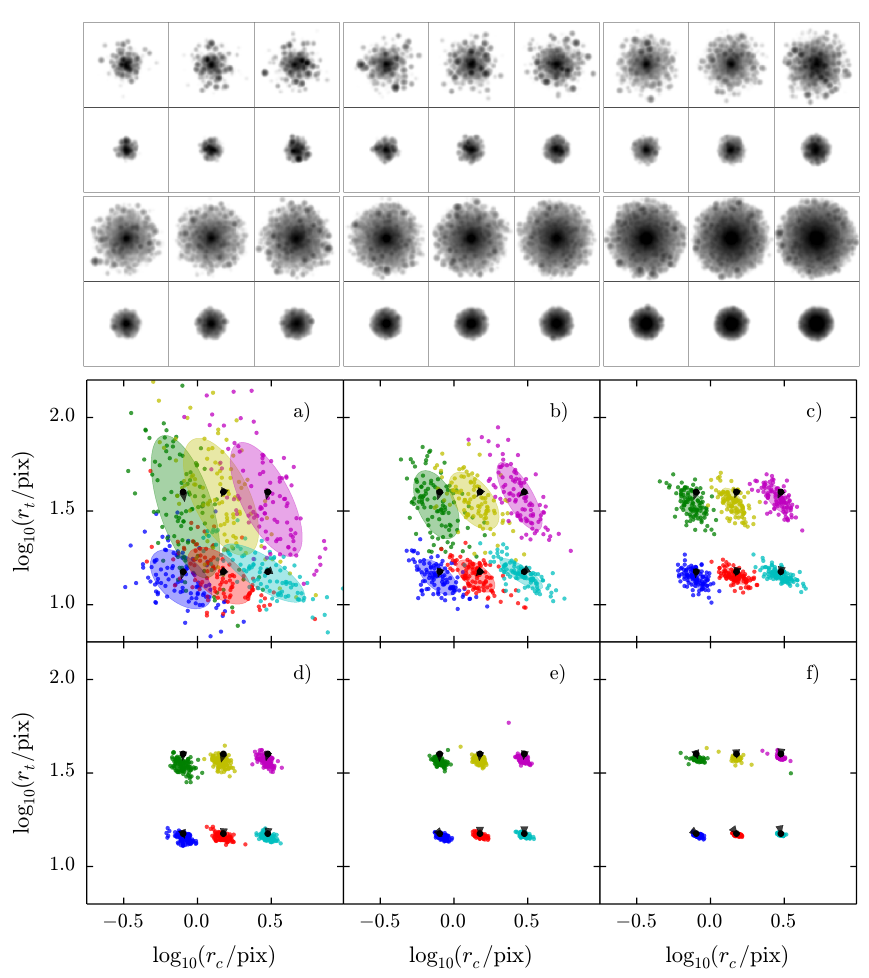
Fig.2. The same as in Fig.1, but for 100 Myr